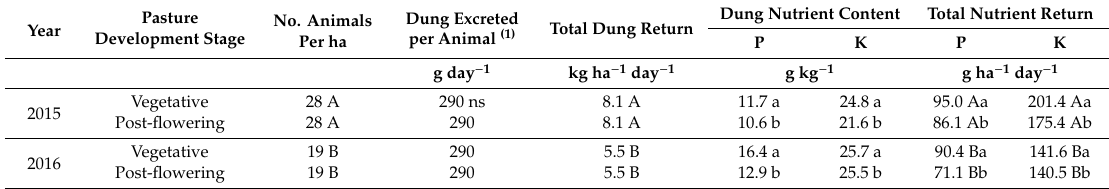
Table 1. Phosphorus (P) and potassium (K) content in dung sampled at di ff erent pasture development stages in 2015 and 2016 winter stocking periods of a no-till integrated soybean-sheep production system. Results are the averages of low and moderate grazing intensities.